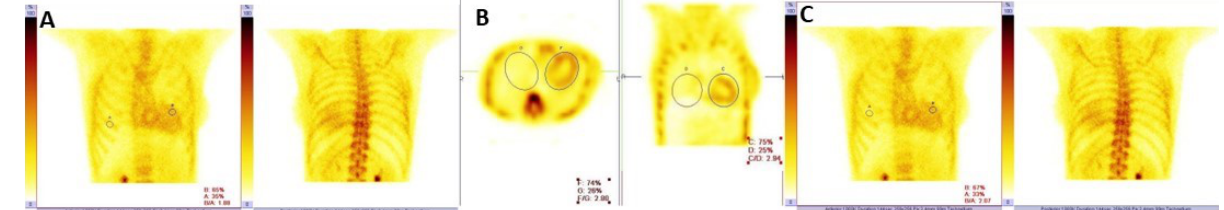
Figure 1. 46 year old female patient with 3 on the bone scan a visual score, H/Rib = 1.88 (image ( A )), H/Cl region = 2.94 and 2.80 on SPECT images (image ( B )) followed by 2.07 on static images (image ( C )); genetic testing revealed the presence of ATTRm with Glu74Gln genetic mutation; the eGFR value (calculated by MDRD and Cockcroft-Gault formula) determined stage 1 kidney disease. Images